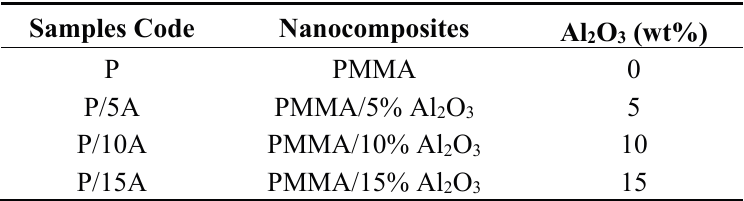
Table 2. The details of fabricated composites.